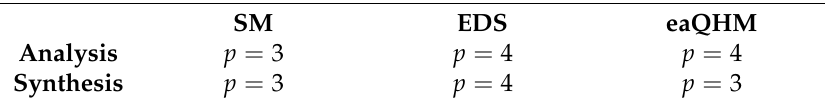
Table 3. Comparison of the number of real parameters p per sinusoid k per frame m for the analysis and synthesis stages of the SM, EDS, and eaQHM. The table presents the number of real parameters p to estimate and to resynthesize each sinusoid inside a frame.